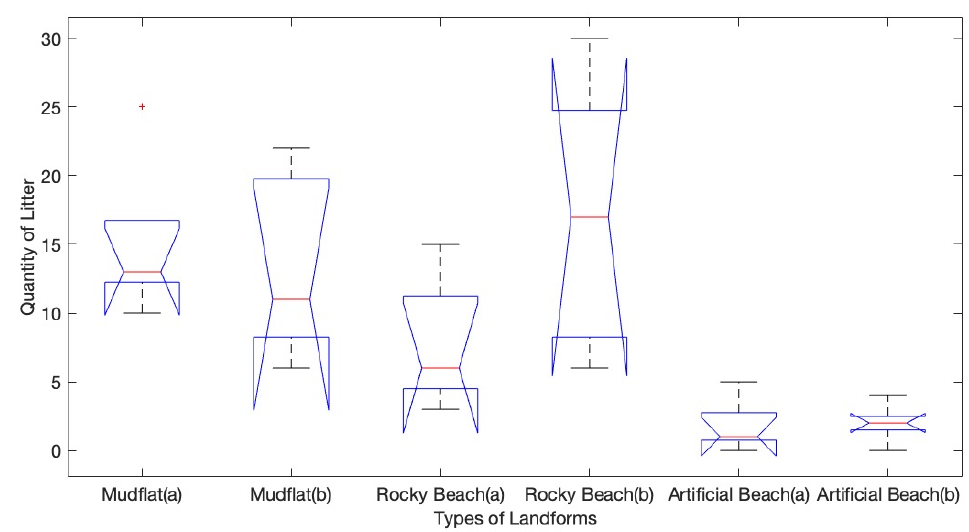
Figure 6. Result of Univariate Analysis of Variance in different landforms from the survey.